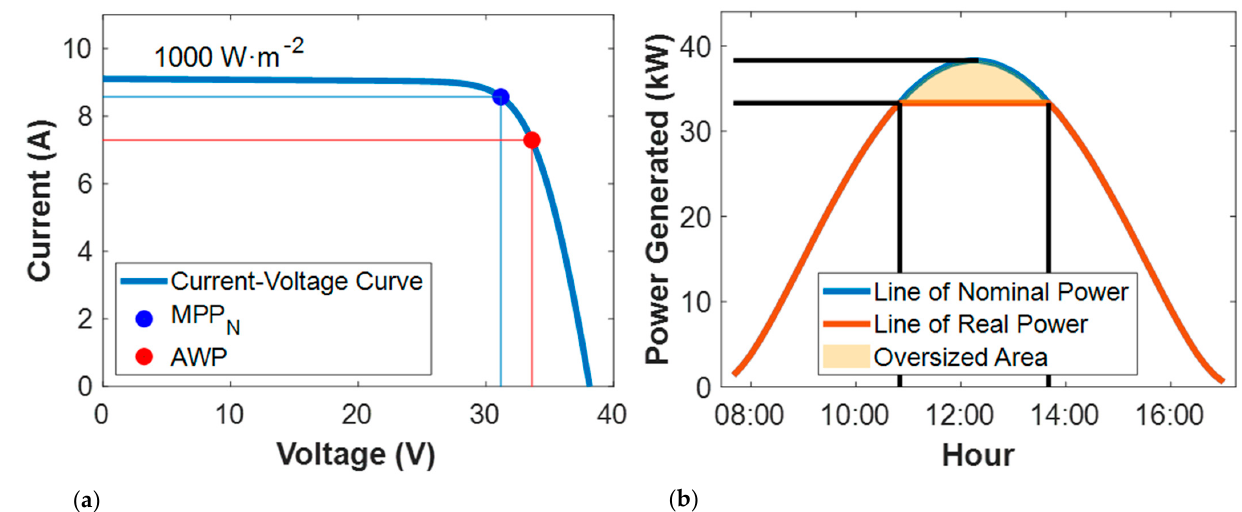
Figure 2. ( a ) Current-Voltage curve and nominal and real points of maximum power (MPP N and AWP of operation and ( b ) example of power generated by the photovoltaic generator. MPP N : nominal point of maximum power operation. AWP: actual working point.